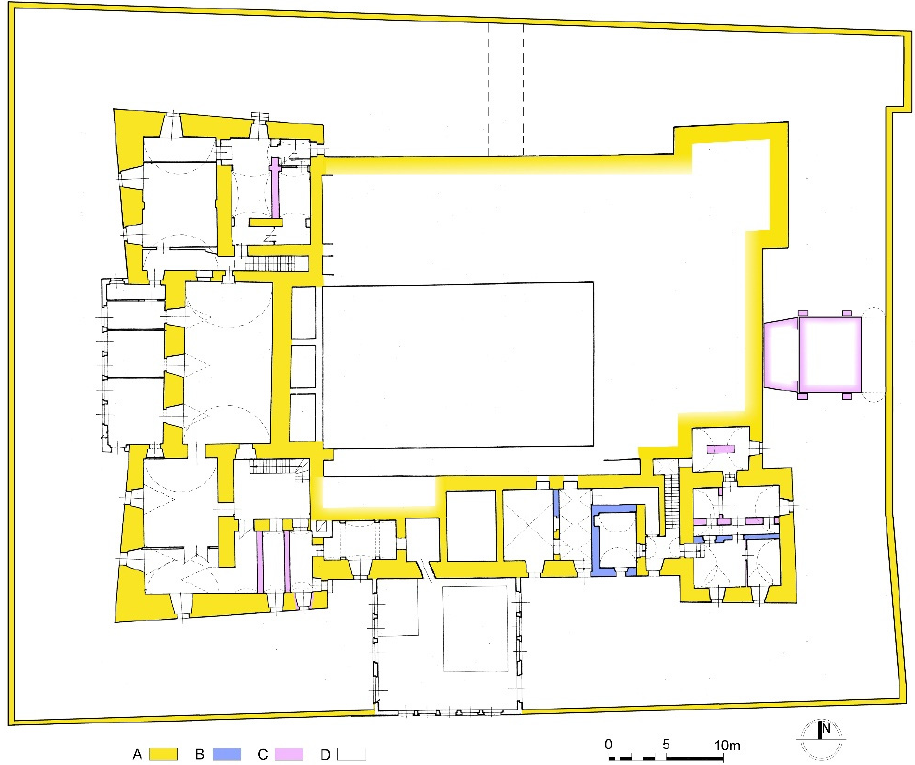
Figure 7. Prószków castle: cellar floor plan with chronological stratification of the walls. Legend: A—Renaissance (approximately 1563); B—Baroque (1667–86); C—1881; D—walls unknown and from the 20th century, created by authors.